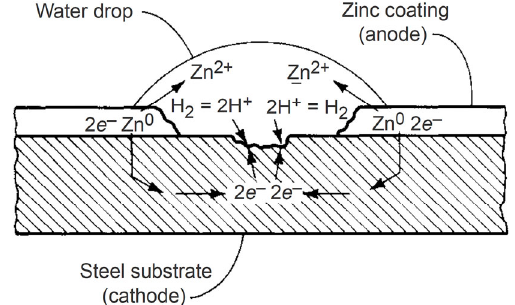
Fig. 16 Sacrificial protection of the steel substrate at a void in zinc coating. Reproduced with permission from Ref. [88], © ASM International,